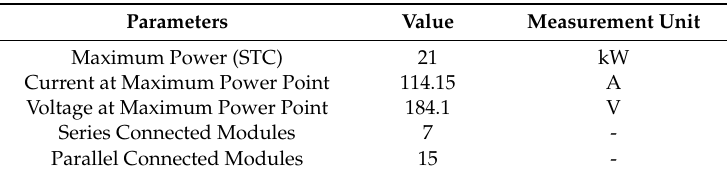
Table A2. Parameters of the PV system.